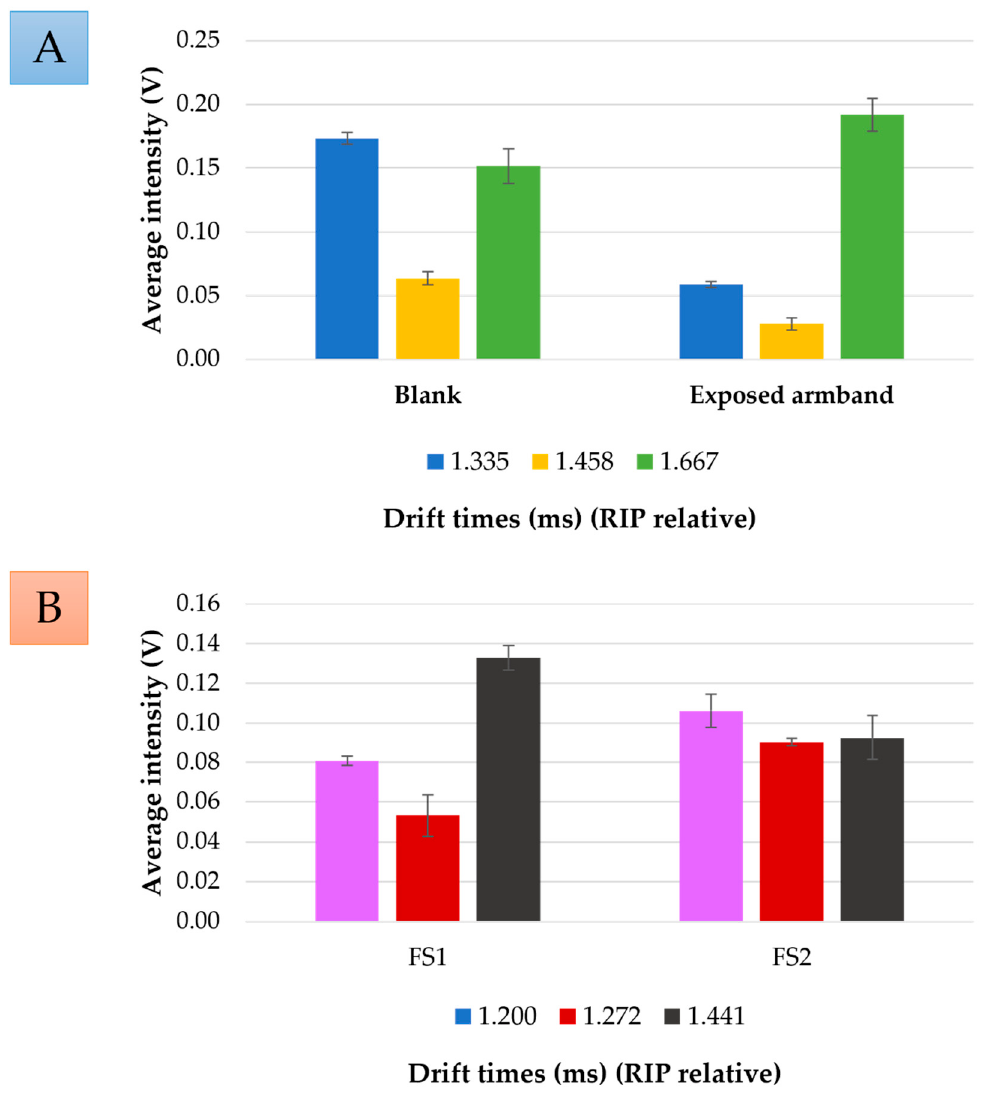
Figure 4. ( A ) Fingerprint obtained from the blank and exposed armbands signals based on the drift times obtained from LDA. ( B ) Fingerprint obtained from the exposed armbands to different fire scenes signals based on the drift times obtained from LDA.